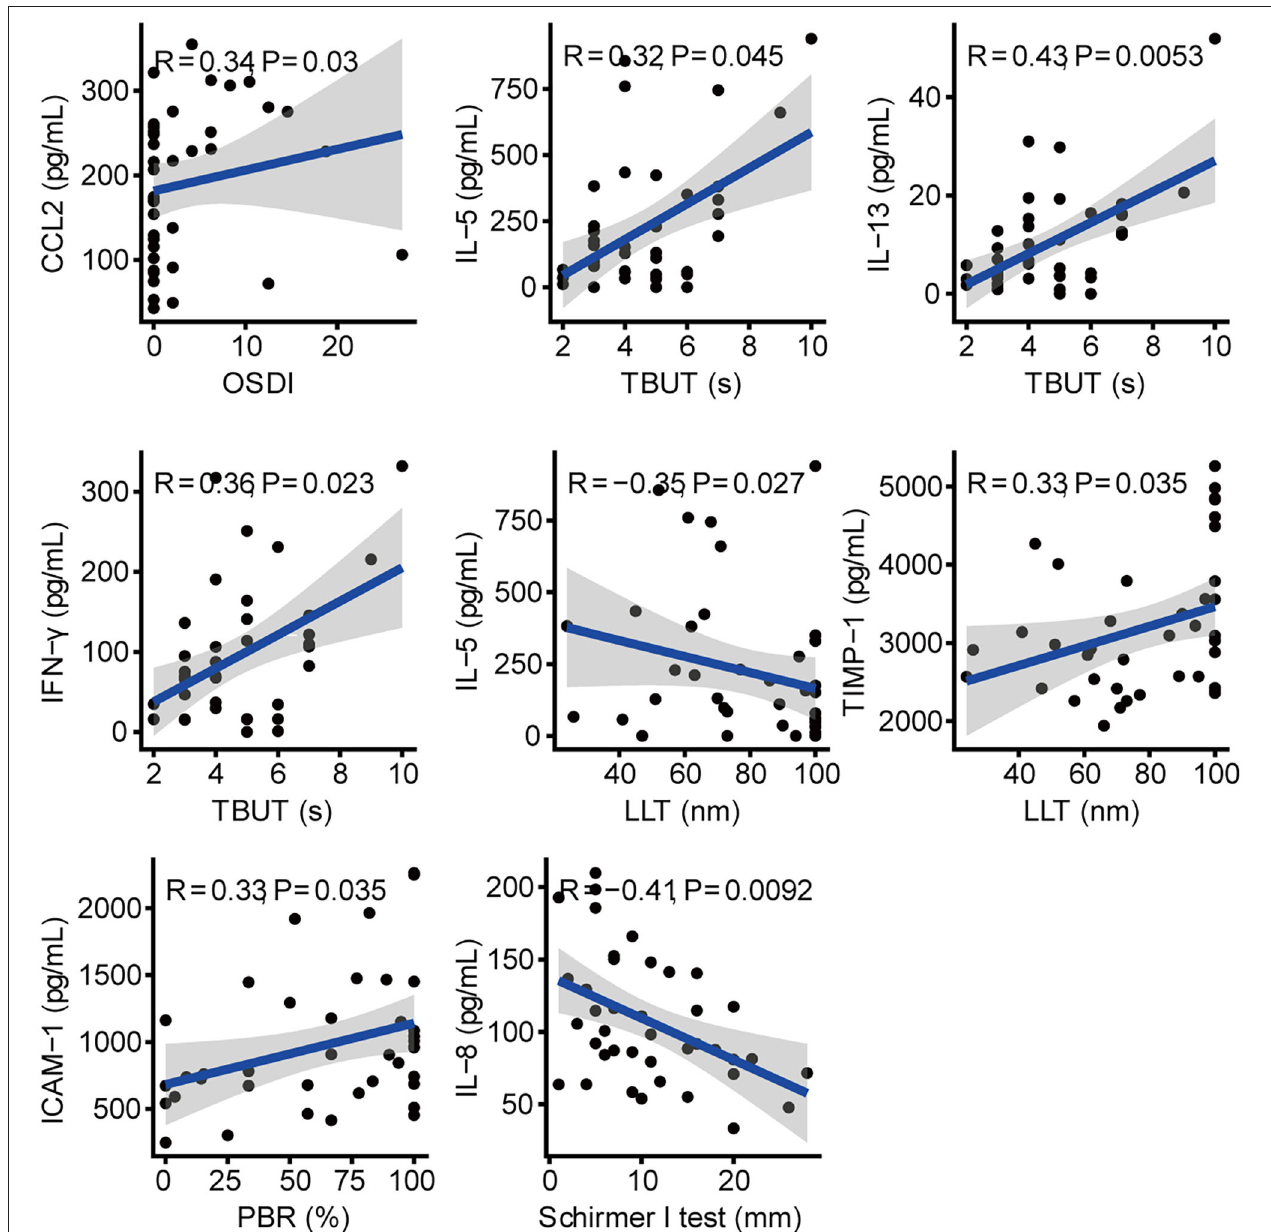
FIGURE 3 | Correlation between cytokines and clinical parameters in schizophrenic patients.